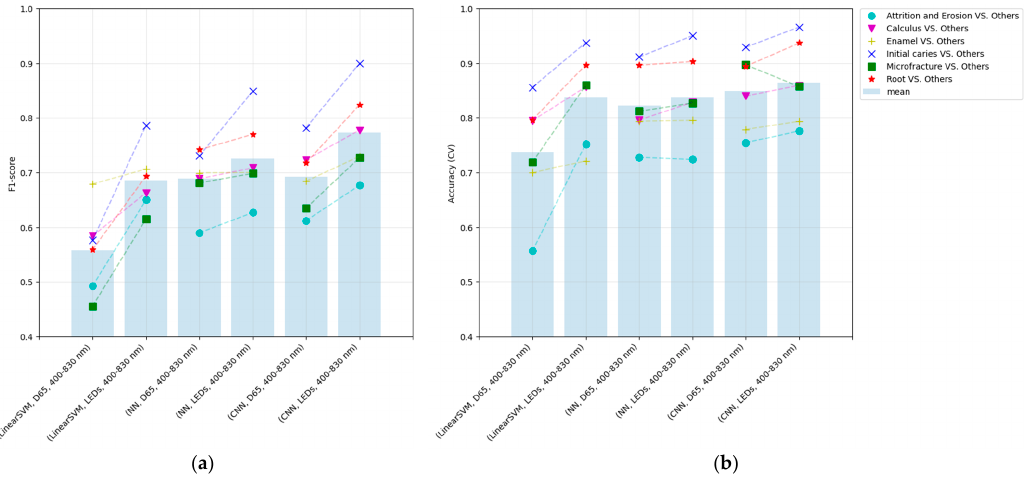
Figure 10. The performance of each method in the five-fold cross-validation: alternating optimization (linear-SVM), the proposed method with only FCL (NN), and the proposed method with CNN (CNN): ( a ) F1-score and ( b ) accuracy.